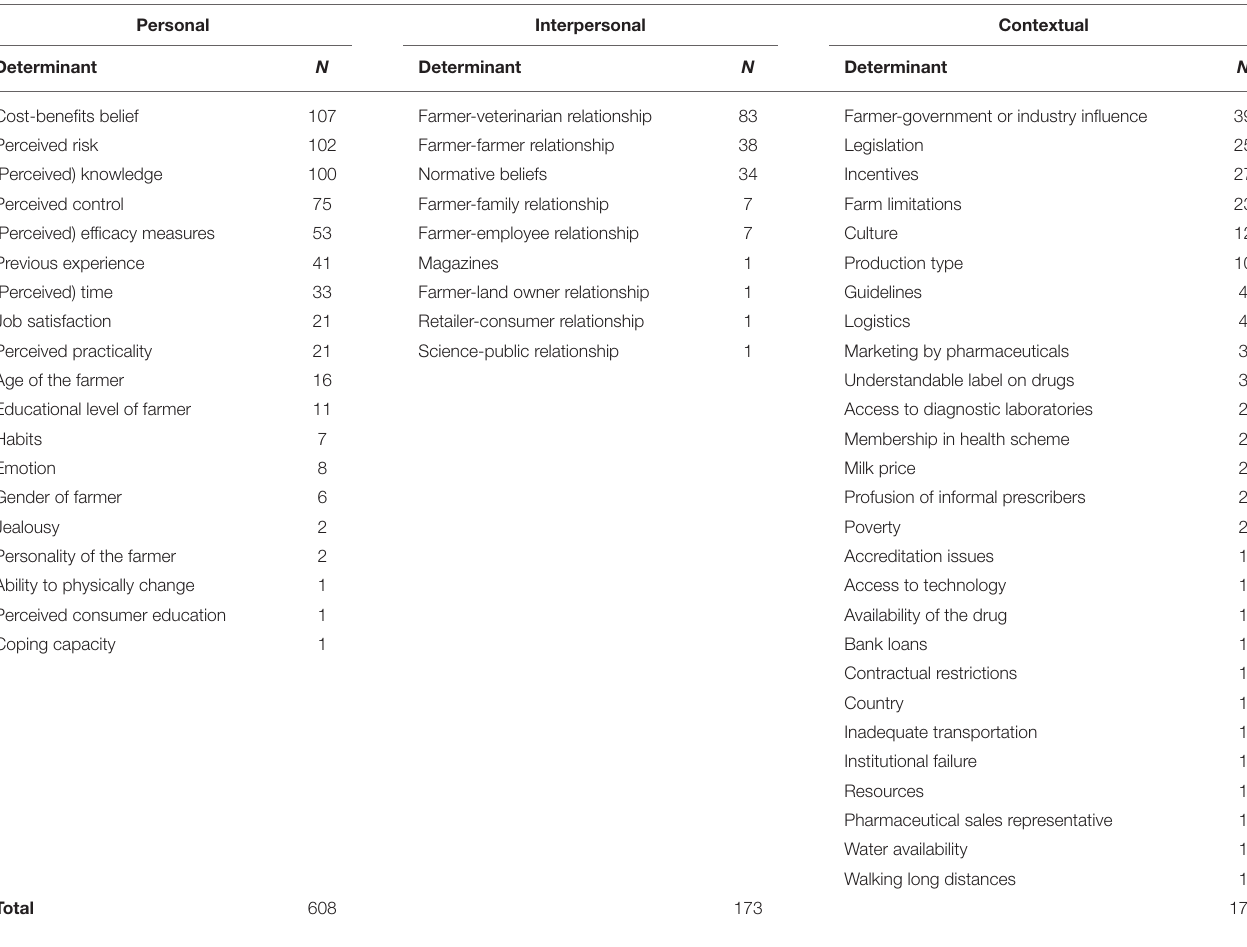
TABLE 4 | Summary of farmers’ behavior constructs described in 146 peer-reviewed studies related to cattle disease prevention and control and indexed in Pubmed and Web of